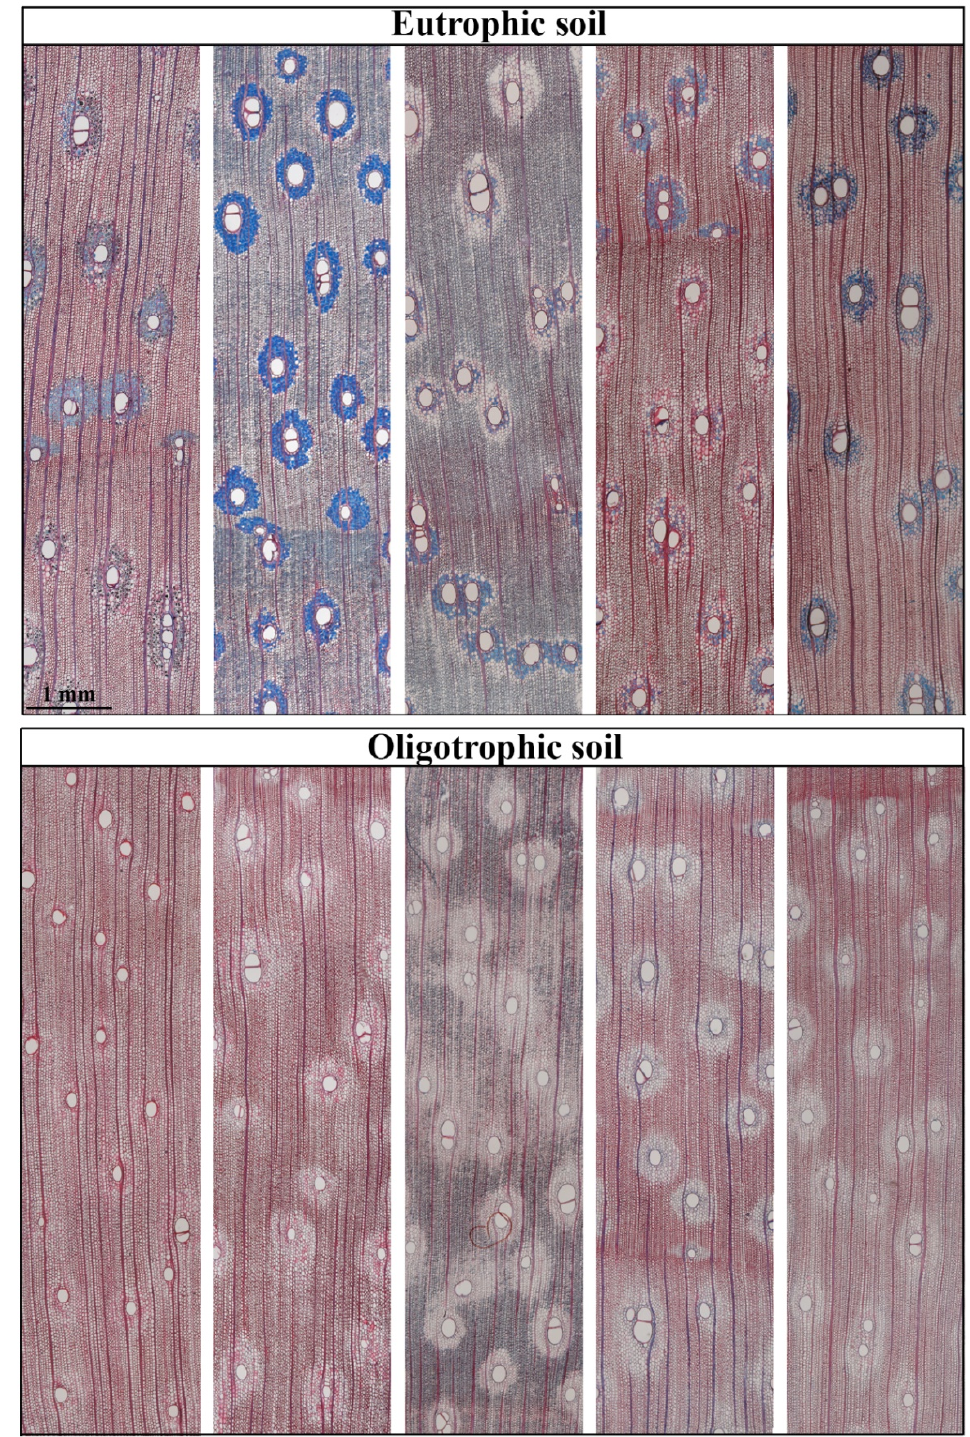
Figure 2. Cross-sections of Enterolobium contortisiliquum 9-year-old trees wood in eutrophic soil and oligotrophic soil. Note abundant storage compounds inside vessel-associated parenchyma cells in the wood of trees grown in eutrophic soil.